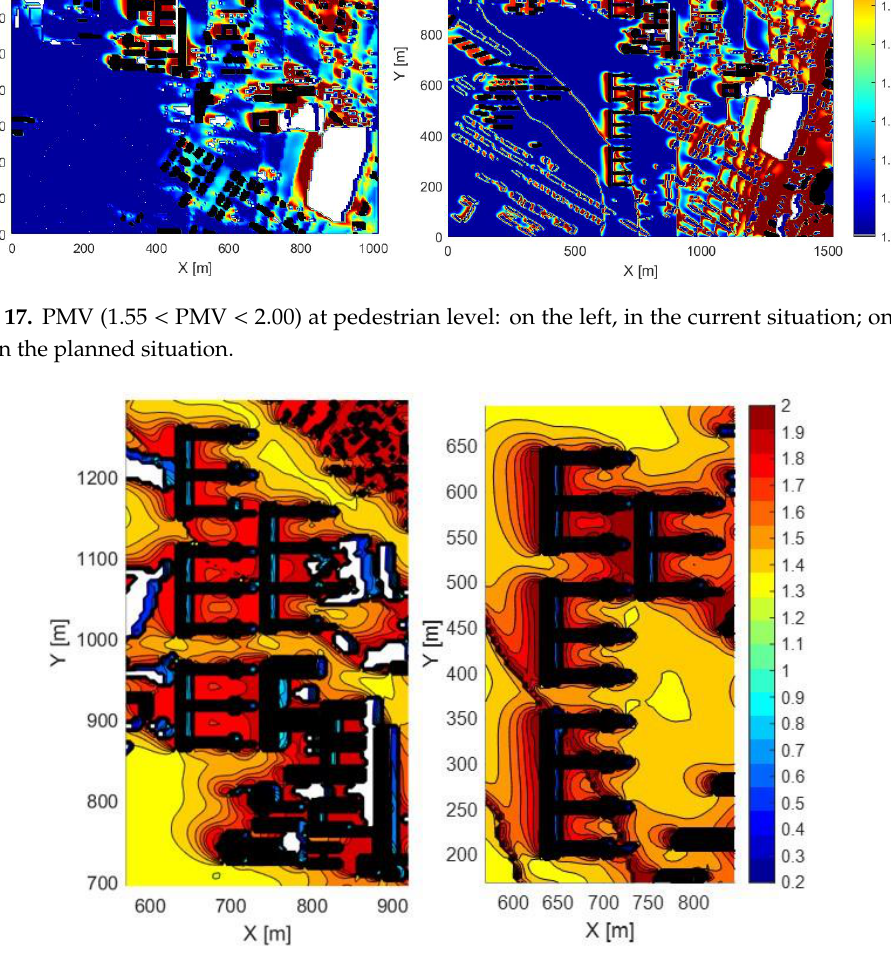
Figure 18. Comparison of the PMV [-] at pedestrian level in the new buildings and in the existing ones: on the left, the northern complex of proposed buildings with the old Campus; on the right, the southern complex of proposed